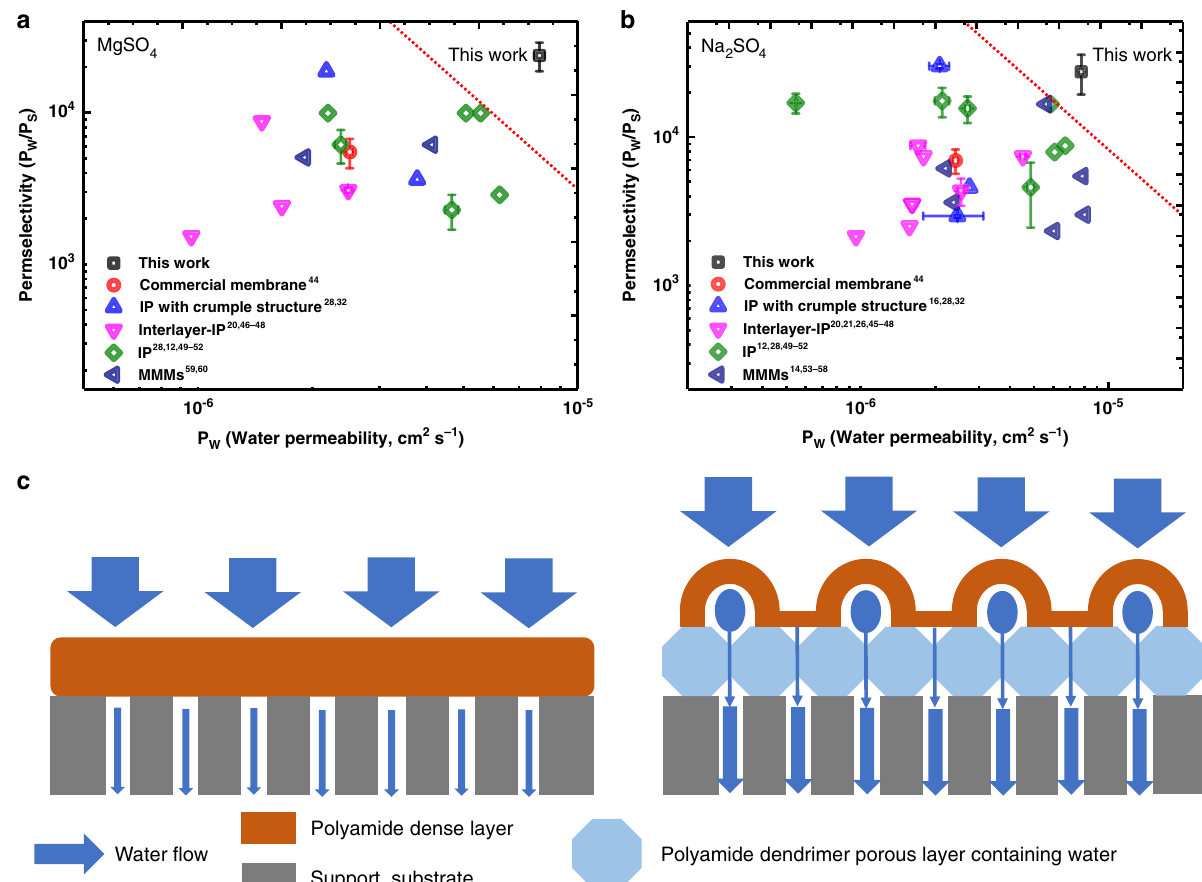
Fig. 6 Water permeability and water − salt selectivity. a , b Correlation between water permeability and water − salt selectivity for the asymmetric polyamide membrane and the commercial as well as reported other types of polyamide membranes in literatures. The asymmetric polyamide membrane was prepared on the PSF-G4D-1 substrate and the reaction time was 60 s. These data were all obtained from corresponding MgSO 4 or Na 2 SO 4 experiments. The dashed red line is the permeability − selectivity trade-off (upper-bound line) for current different types of polyamide membranes, such as commercial polyamide membrane (Commercial membrane), polyamide membrane prepared by interlayer (Interlayer-IP), crumpled polyamide membrane (IP with crumpled structure), mixed matrix polyamide membranes (MMMs), and traditional IP membrane (IP). c Schematic diagrams of the transport path of water across the traditional and asymmetric polyamide